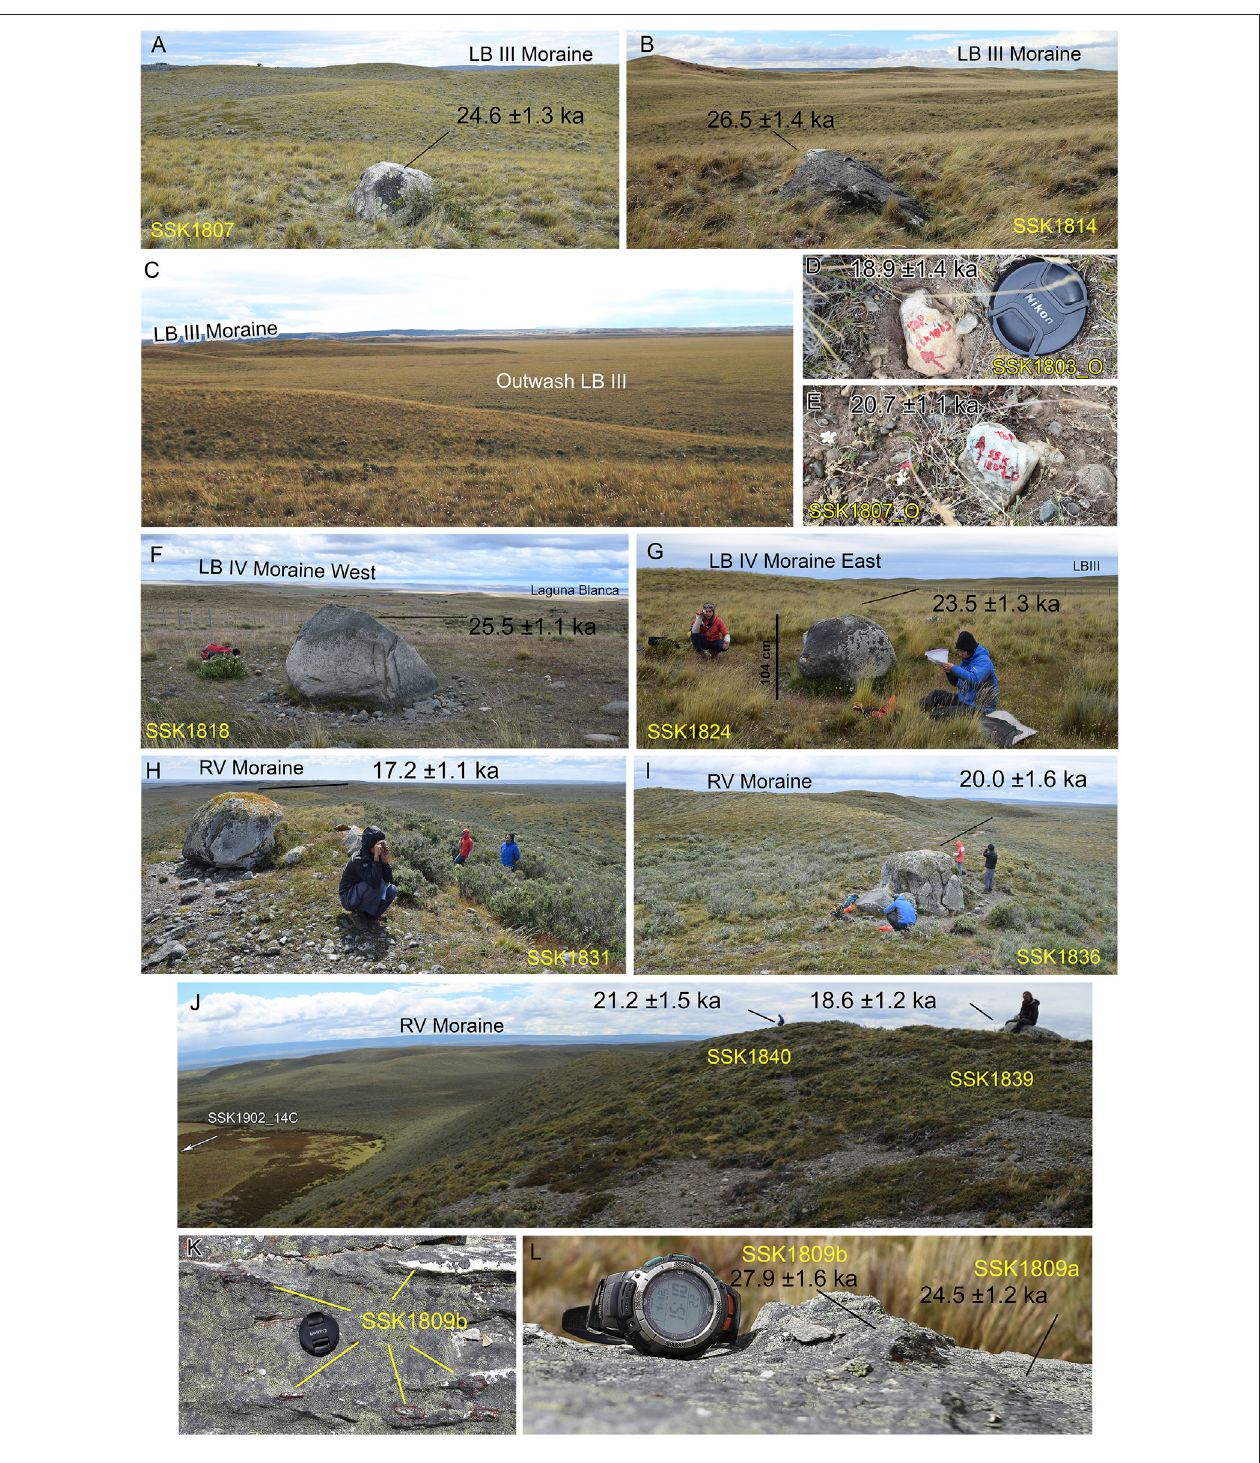
FIGURE4| Examples ofmorainebouldersamplesandoutwashcobblescollected. (A,B) MorainebouldersfromLBIII. (C) LBIIIoutwash. (D,E) Cobblescollected from LB III outwash. (F,G) Laguna Blanca IV. (H – J) RV moraine. (K,L) Sample SSK1809 showing the sampled quartz vein and sampled boulder surface.